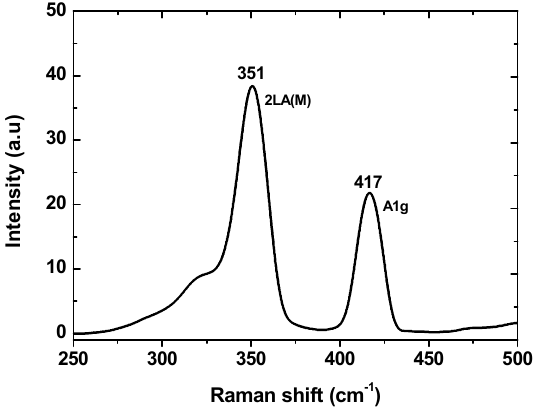
Figure 5. Raman spectra of WS 2 nanoflowers.